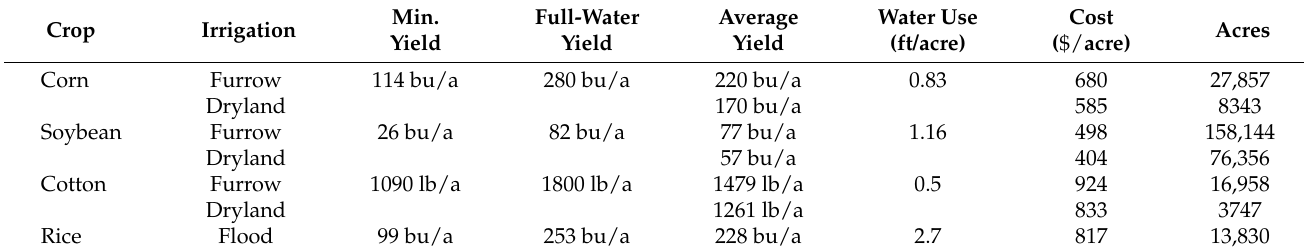
Table 2. Summary of observed and estimated parameters for Sunflower County,